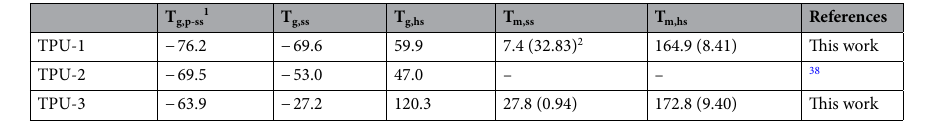
Table 4. The transition temperatures (ºC) of the TPU-1 to TPU-3 from the DSC analysis. 1 Glass transition temperature of soft segment as a standalone polymer. 2 The integral of peaks in J g −1 .